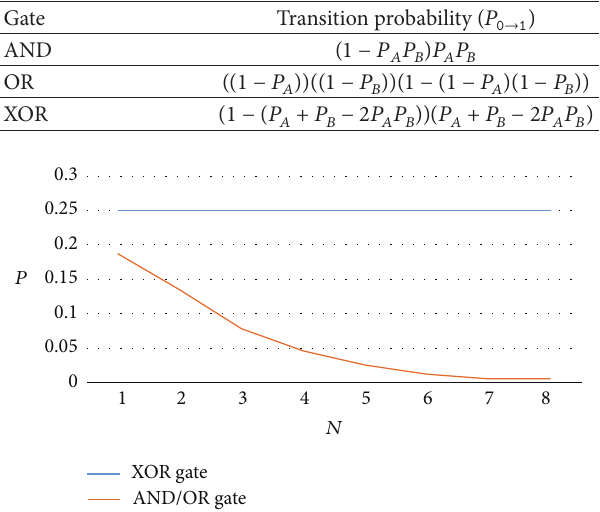
Algorithm 1 (for XOR-FREE processing of convolutional